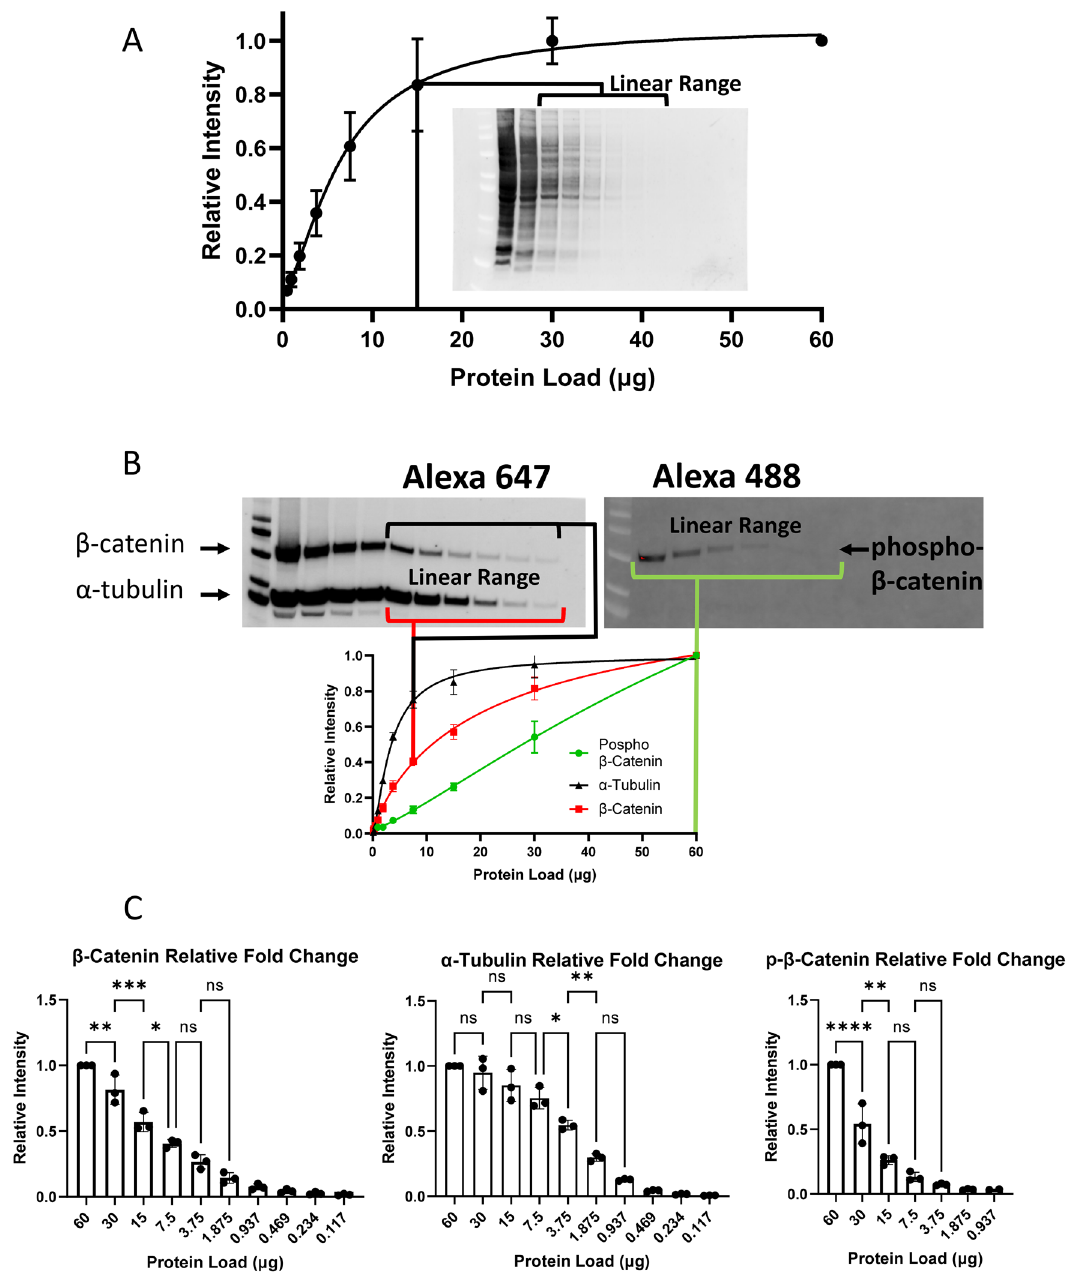
Figure 1. Fluorescence data analysis. Three separate blots were independently generated from the same 1:2 sample dilution series of an equalized pool of cell lysates starting from approximately 60 µg total protein loading. The membranes were probed with a mixture of three primary antibodies against β-catenin, phospho-β-catenin and α-tubulin followed by a solution of mixed fluorescent and chemiluminescent secondaries (see "Methods" section and Table 2). ( A ) Representative image of the total protein fluorescent signal from each membrane and associated plot of the average relative fluorescence intensity for each dilution (error bars represent the SEM from the average of three, separate experiments). ( B ) Representative image of the fluorescent signal from each protein target and associated plot of the average relative fluorescence intensity versus total protein loading amount (error bars represent the standard error of the mean (SEM) from the average of three, separate experiments). The bracketed region for each target protein represents the linear dynamic range of quantitation. ( C ) Bar charts depicting the average, relative signal intensity versus total protein loading amount for the three experiments (error bars represent the standard deviation (SD) from the average of three, separate experiments). Data analysis was performed according to Fig. 4, column 6 (Relative Normalized Ratio (RNR)). The statistical difference between each level of protein load is shown where **** p -value < 0.0001, *** p -value < 0.0002, ** p -value < 0.0021, * p -value < 0.0332; ns non-significant. Full blot images for ( A ) are provided in the supplemental data (Supplemental Fig.